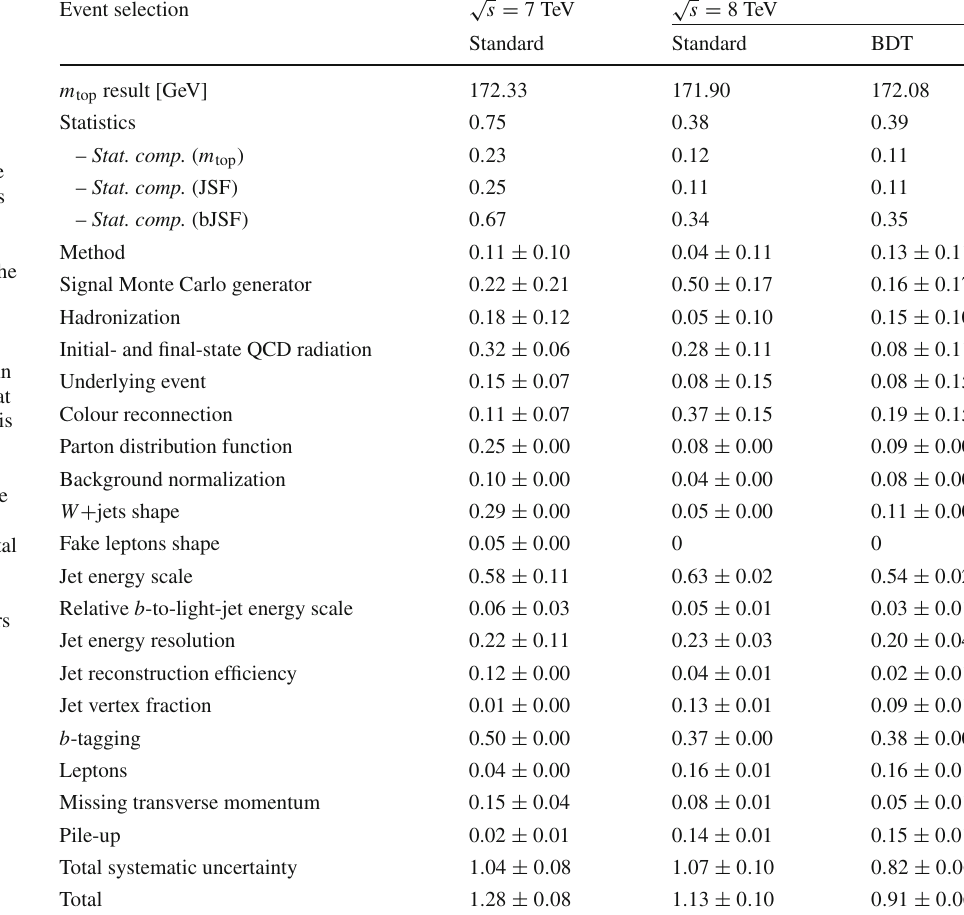
Table 3 Systematic uncertainties in m top . The measured values of m top are given together with the statistical and systematic uncertainties in GeV for the standard and the BDT event selections. For comparison, the result in the t ¯ t → lepton + jets √ s = 7 TeV from channel at Ref. [9] is also listed. For each systematic uncertainty listed, the first value corresponds to the uncertainty in m top , and the second to the statistical precision in this uncertainty. An integer value of zero means that the corresponding uncertainty is negligible and therefore not evaluated.